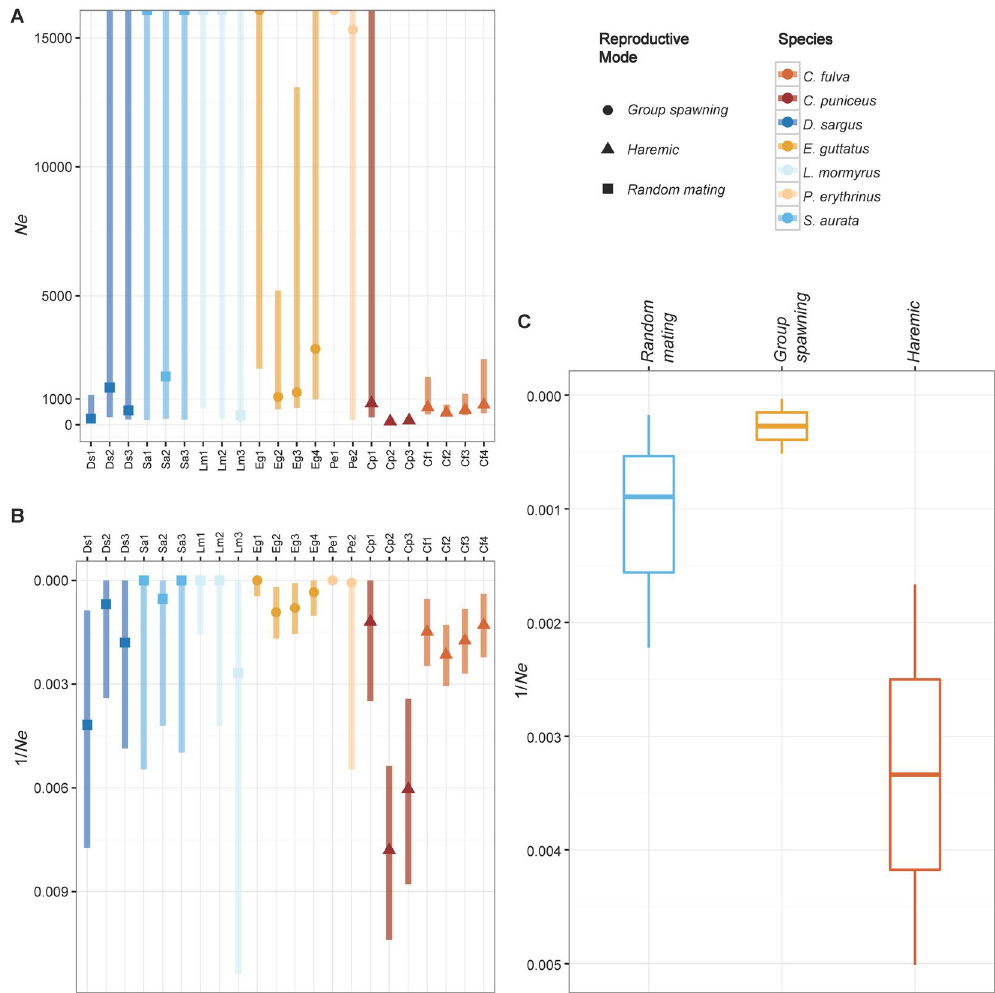
Figure 5. Effective population size ( ˆ N ) estimates, obtained with LDNe for multiple populations of the seven e species under study. Bars in the tones of blue: protandrous species; bars in the tones of orange: protogynous species. ( A ) ˆ N values (up to infinite); ( B ) ˆ N 1/ (note the reverse y axis as an aid to visualize ˆ N e e ˆ N 1/ values imply lower ˆ N ); ( C ) ˆ N 1/ (reverse y axis) by reproductive e e e